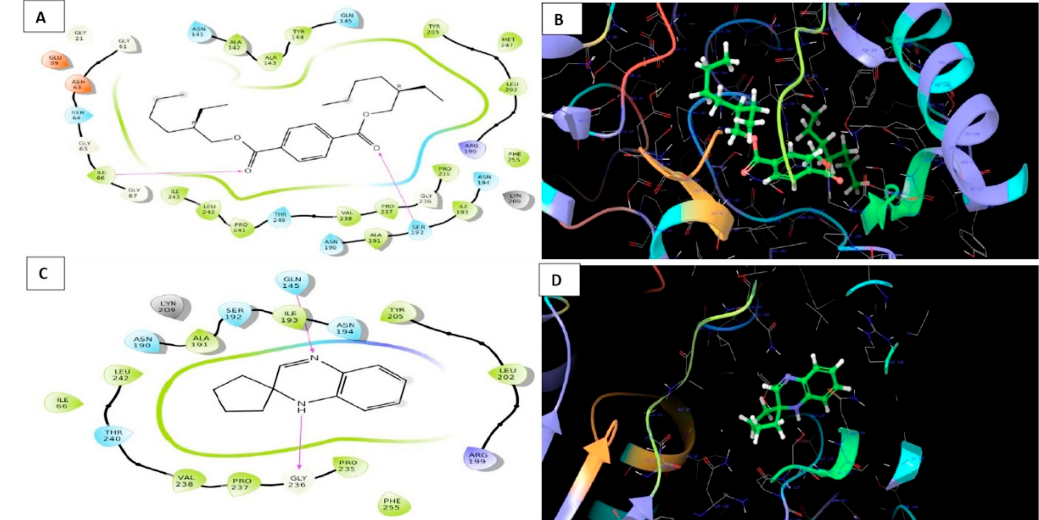
Fig. 2B. Molecular Docking of actinobacterially synthesized ligands with modeled SDR protein FOXG_00472 in Fusarium oxysporum f. sp. lycopersici ( FOL ). (A) 2D structure of FOXG_00472-1,4-Benzenedicarboxylic acid, Bis ( 2-ethyhexyl) ester complex showing the interacting aminoacid residues. (B) 3D structure of FOXG_00472- ligand complex showing the interaction of 1, 4-Benzenedicarboxylic acid, Bis(2-ethylhexyl) ester at the active site of modeled SDR protein FOXG_00472. (C) 2D structure of FOXG_00472 – Spiro [Cyclopentane-1,2’(1’H)-quinoxaline] complex showing the interacting aminoacid residues. (D) 3D structure of FOXG_00472 – ligand complex showing the interaction of Spiro [Cyclopentane-1,2’(1’H)-quinoxaline] at the active site of modeled SDR protein